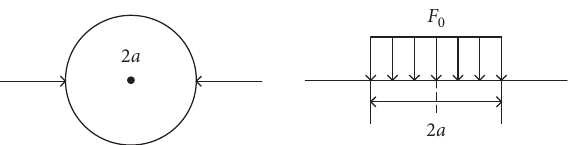
Figure 1: Schematic diagram of the vertical load borne by the pavement.